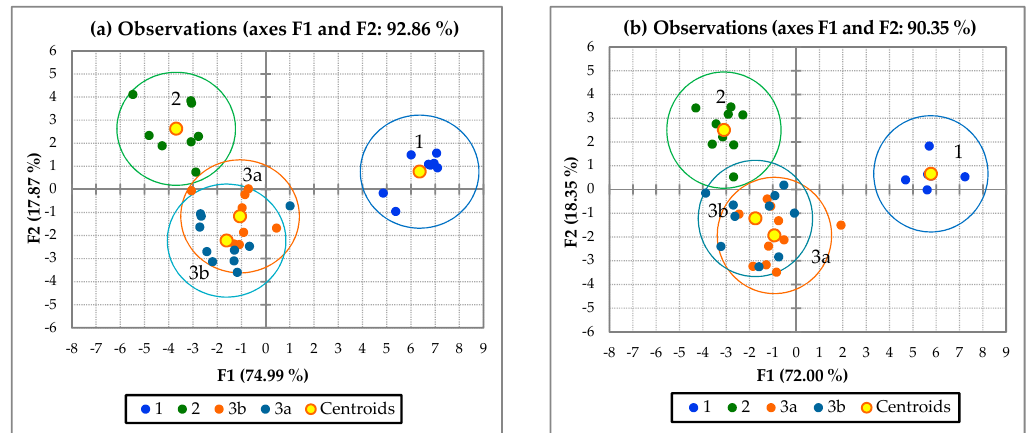
Figure 4. Dendrogram of clusters of sampling sites according to surface water qualities at (Dlink / Dmax) × 100 < 60 and (Dlink / Dmax) × 100 < 35 for sub-clusters (3a and 3b): ( a ) dry season and ( b ) wet season. In the dry season (cluster 1 obtained f1, f4, f7, f8, f9, f14, c1, and c11; cluster 2: f1, f12, c8, c12, c14, c15, R2, R5, and R6; cluster 3a: f3, f5, f6, f10, f13, c4, c9, c10, R3, and R4; cluster 3b: f2, c2, c3, c5, c6, c7, c13, and R1). In the wet season (cluster1: f1, f3, f6, f9, f14, and c1; cluster 2: f4, f10, f11, c2, c7, c8, c9, c11, and c15; cluster 3a: f5, f8, f13, c6, c10, c12, c13, c14, R1, and R5; cluster 3b: f2, f7, f12, c1, c4, c5, R2, R3, R4, and R6). Note: (R: river, c: primary canal, f: field canal; 1: inside full-dike, 2: inside semi-dike, 3: outside of dike).